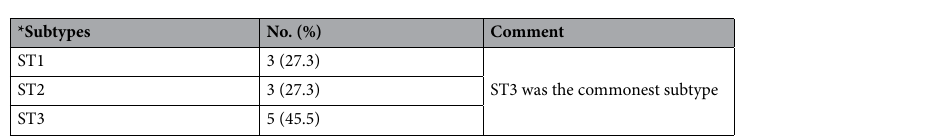
Table 4. Molecular subtyping of the sequenced isolates ( n = 11). *15/80 isolates were sent to Rome, Italy, for sequencing, with only 11/80 sequences yielding high-quality sequence